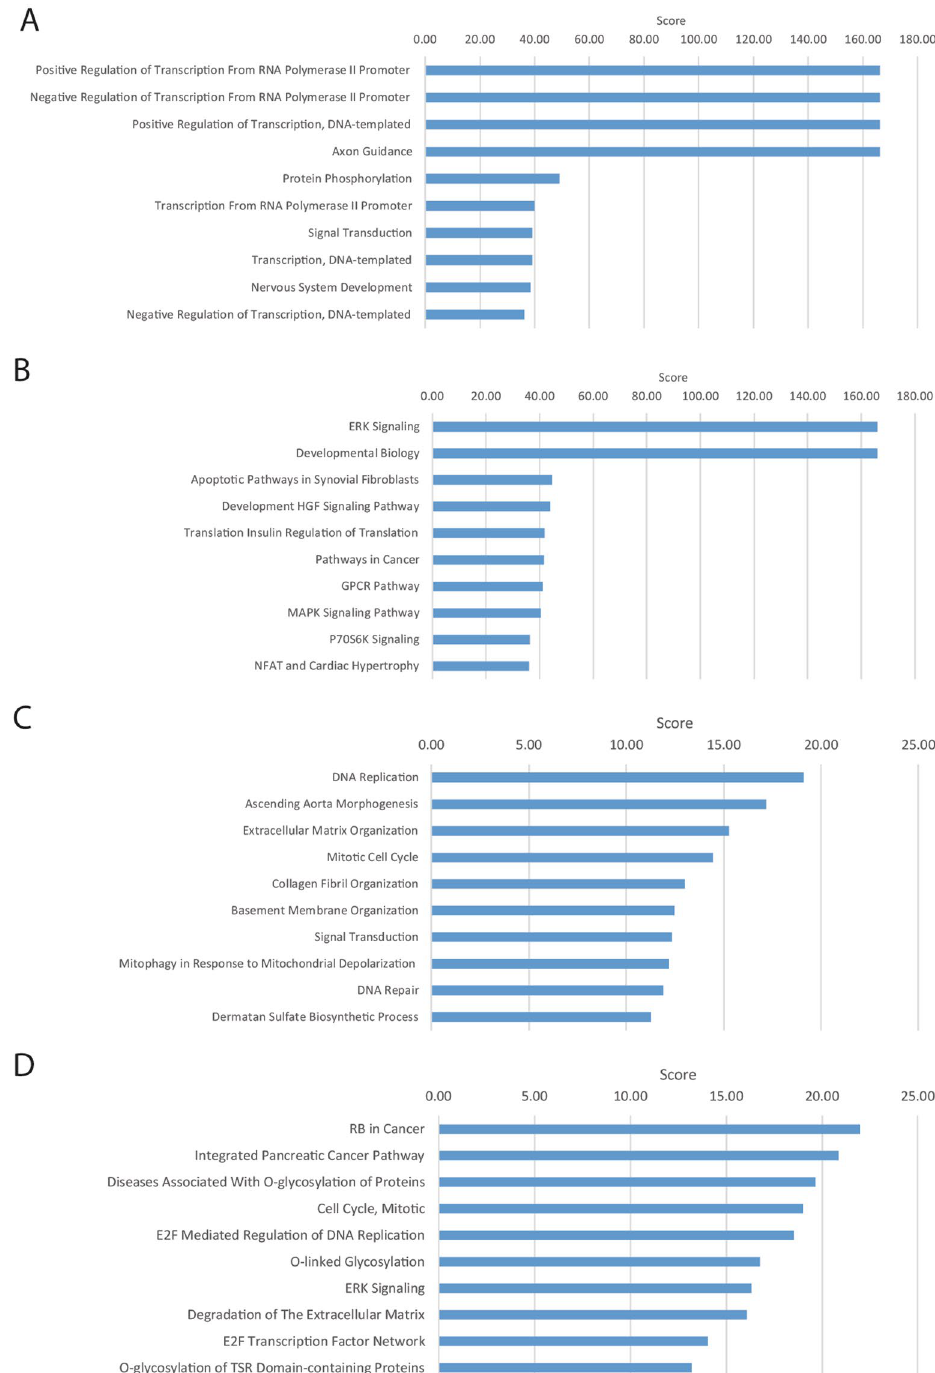
Figure 2. GeneAnalytics analysis of all 7288 putative miRNA targets ( A , B ) and of the 234 negatively correlated differentially expressed miRNA targets ( C , D ). Presented are the top 10 enriched GO terms ( A , C ) and the top 10 enriched pathways ( B , D ). The presented GeneAnalytics score is a transformation ( − log2) of the p-value; hence, higher scores represent stronger